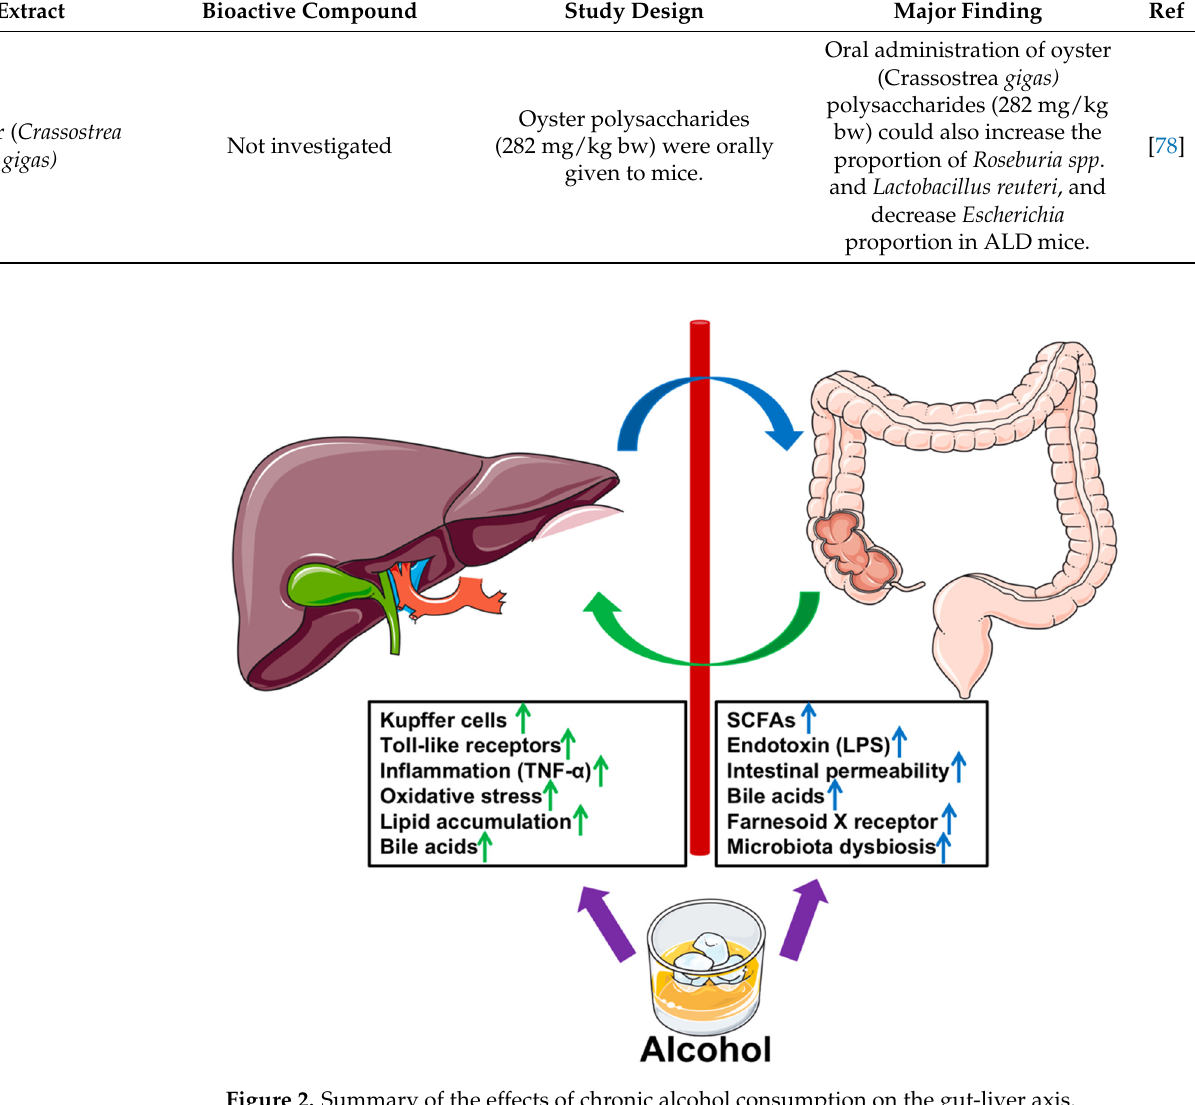
Figure 2. Summary of the effects of chronic alcohol consumption on the gut-liver axis. Table 1. Summary of the protective effect of various natural products against ALD.